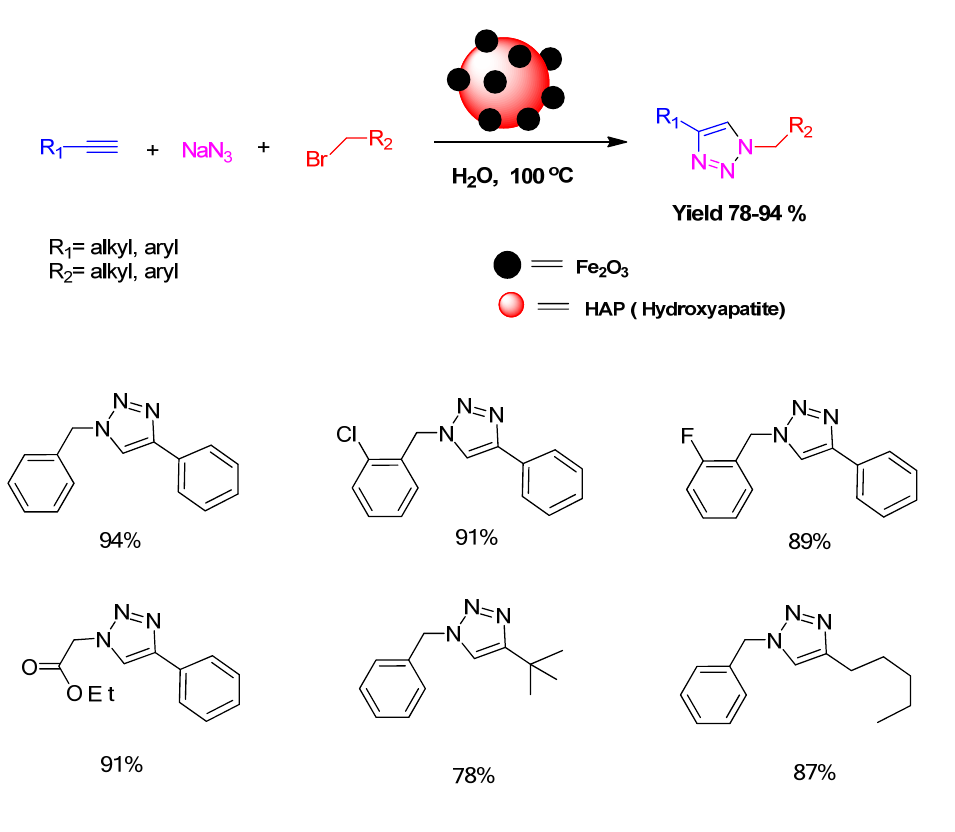
O /HAP catalyzed cycloaddition reaction of alkynes, and in 2 3